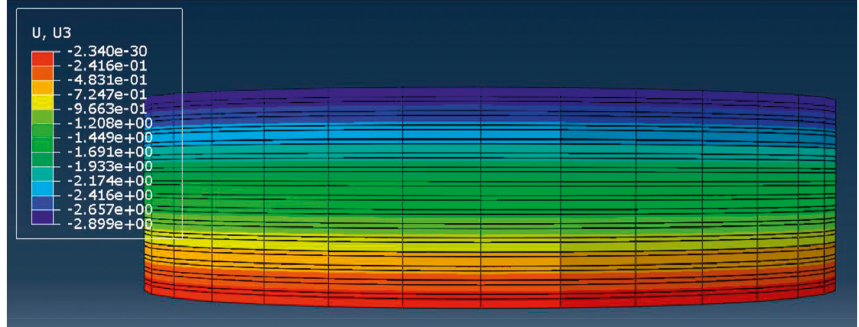
Figure 21: The vertical displacement cloud of the bearing under pure pressure.